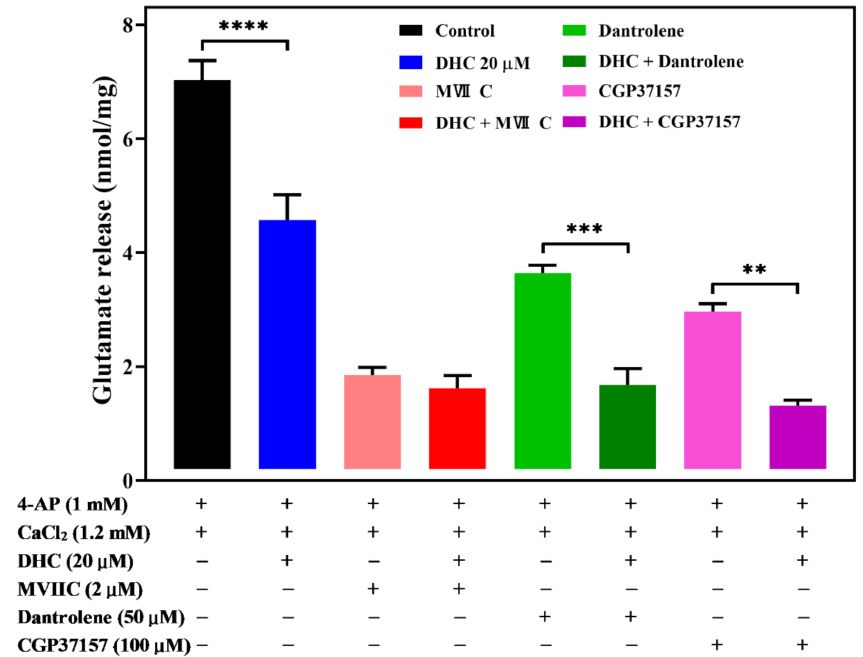
Figure 5. DHC inhibited 4-AP-evoked glutamate release through modulation of N- and P/Q- Ca 2+ channels. Quantitative analysis of glutamate release by depolarizing stimuli (4-AP 1 mM) when synaptosomes were incubated with or without 20 µ M DHC, 2 µ M ω -con-MVIIC, 50 µ M dantrolene, or 100 µ M CGP37157. Data are the means ± SEM. **** p < 0.0001 versus the control group, *** p < 0.001 versus the dantrolene-treated group, ** p < 0.01 versus the CGP37157-treated group ( n = 5). DHC (20 µ M) alone reduced 4-AP-evoked glutamate release ( p < 0.0001). The